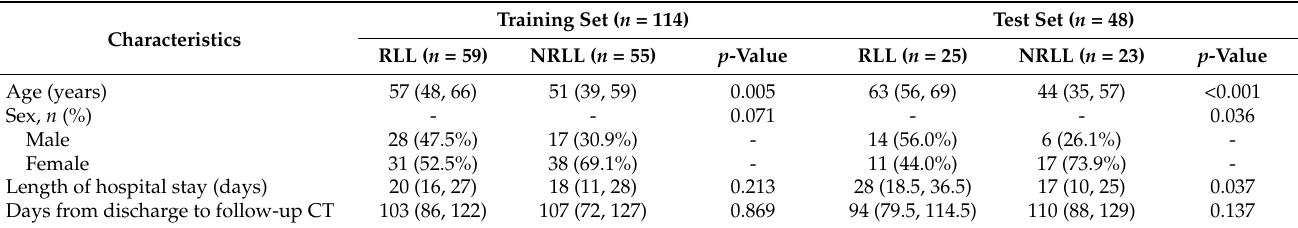
Table 1. Characteristics of patients in the training and test sets.